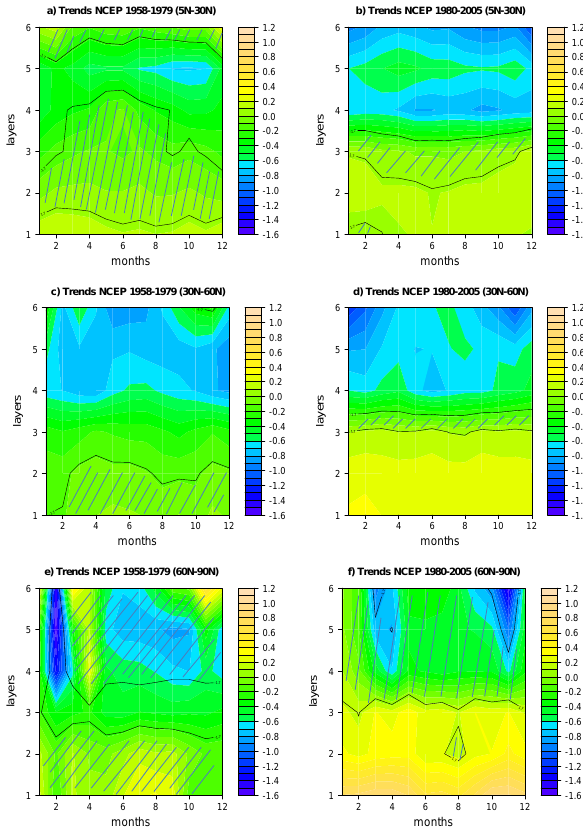
Figure 2. Monthly normalized time series of the layer mean tem- Figure 2 perature at layers 925–500hPa, 500–300hPa, 100–50hPa and 50– 30hPa calculated from NCEP reanalysis and FU-Berlin data sets for the Northern Hemisphere and filtered from natural variations at the latitudinal belts: (a) 5–30 ◦ N, (b) 30–60 ◦ N and (c) 60–90 ◦ N. The respective monthly normalized time series of temperature from RICH data set at levels 850, 500, 50 and 30hPa are illustrated with purple lines as well as the NCEP tropopause pressure normalized monthly means. The trend lines before and after 1979 are superim- posed. The units of vertical axes are in ◦ C except for the tropopause which is in hPa.